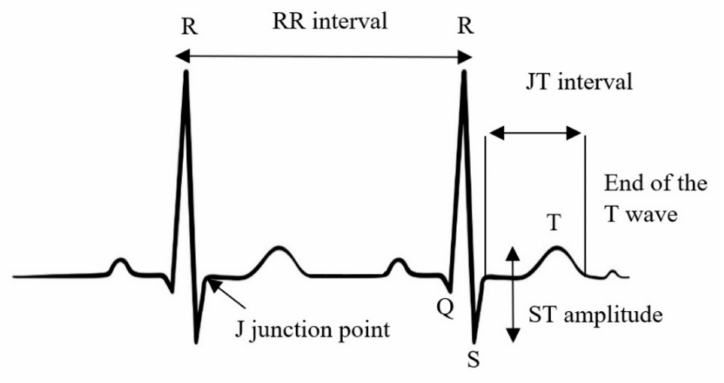
Figure 1. Diagram of typical ECG cardiac intervals and amplitudes used in the